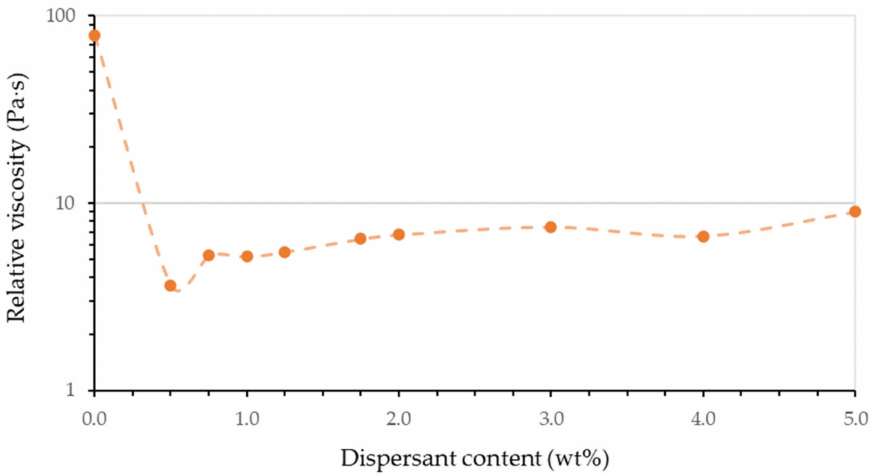
Figure 5. Evolution of relative viscosity at 1.1 s − 1 of shear rate with the dispersant content at 40 vol% alumina resins. Each point corresponds to an average of at least three measured viscosity curves. It has a minimum viscosity of 0.5% dispersant indicating a better dispersion of the particles and the optimum dispersant